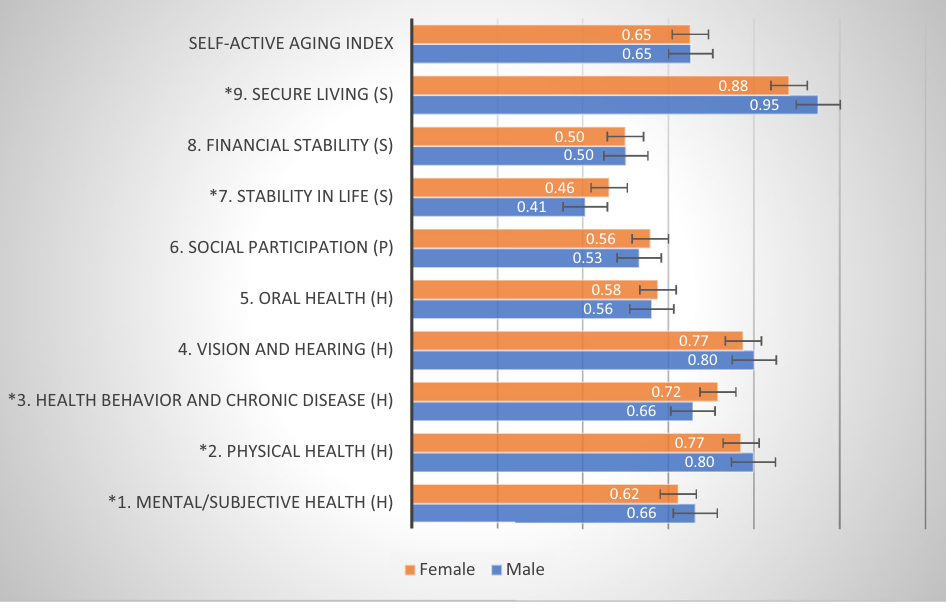
Figure 2. S-AAI scores classified by